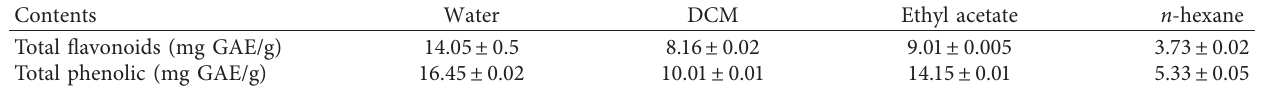
Table 2: Determination of flavonoids and phenolic contents in S.